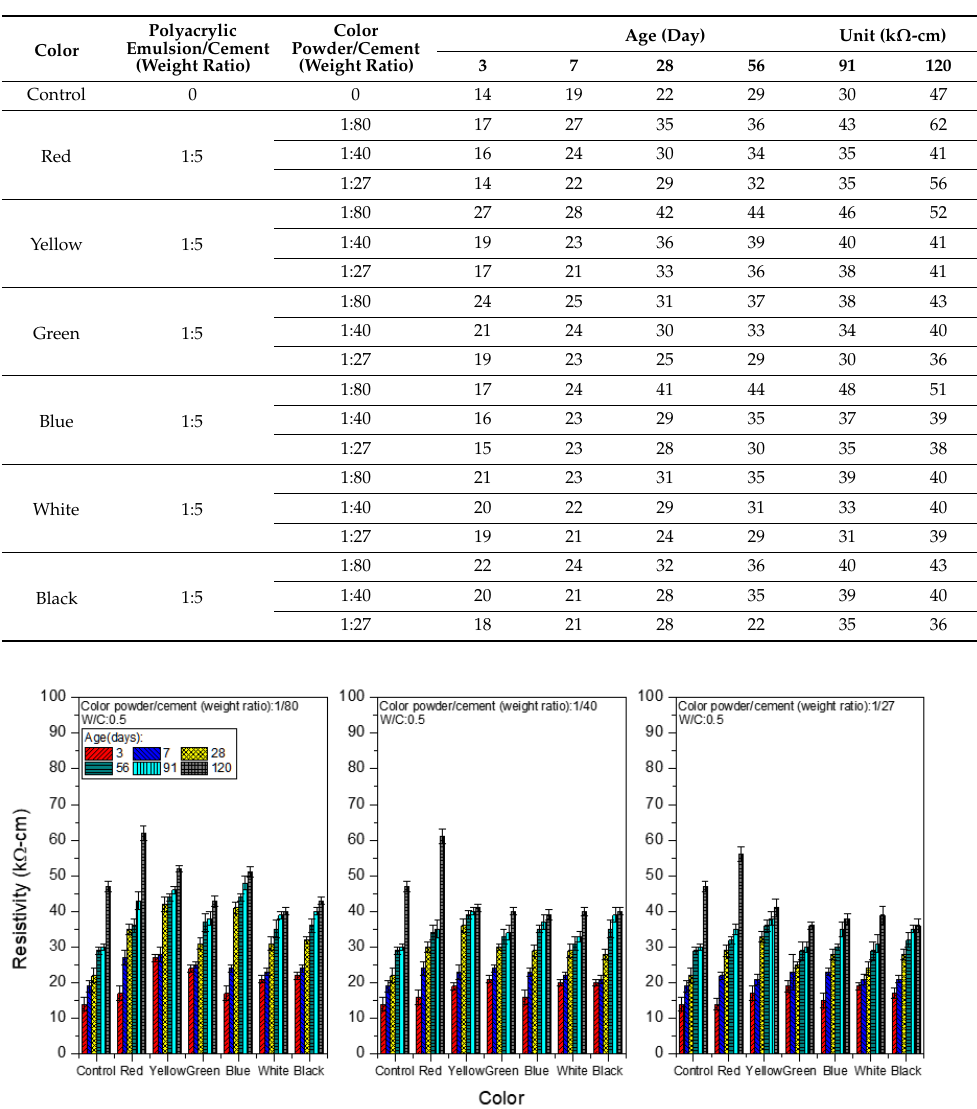
Figure 12. Surface electrical resistivity of colored mortar with different proportions of inorganic color powder.